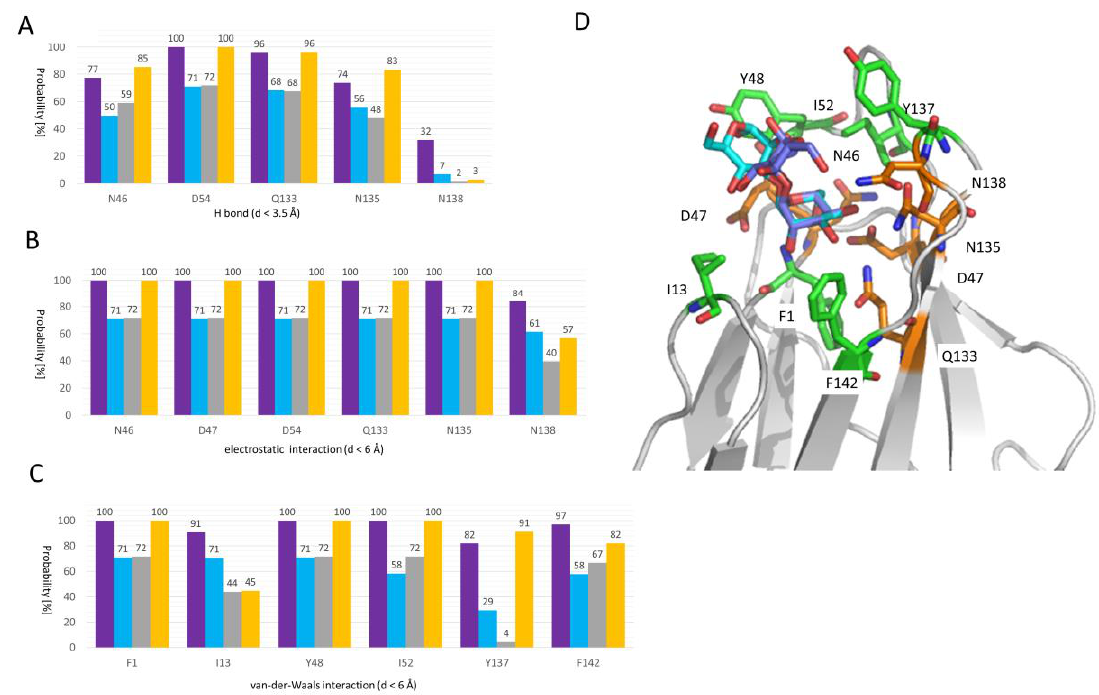
Figure 3. FimH-dimannose interactions as extracted from the MD simulations. The probability of finding a FimH binding site residue within ( A ) H bond, ( B ) electrostatic interaction, and ( C ) van-der-Waals interaction distance ( D ) of the Man α 1,2Man (lilac), Man α 1,3Man (cyan), Man (grey), and HM (orange) ligand is plotted against the residue number. Only residues with a probability of at least 25% for at least one ligand are shown. For more details regarding the calculations see Section 3.4. ( D ) The position of the different listed residues in ( A – C ) is highlighted in the FimH binding site residue within H bond and/or electrostatics interaction range are depicted as red sticks onto the Man α 1,2Man (lilac) and Man α 1,3Man (cyan) FimH conformation representative for cluster #1 (see Figures 4 and 5) and residues within van-der-Waals interaction range are shown as orange sticks on the same structure (white